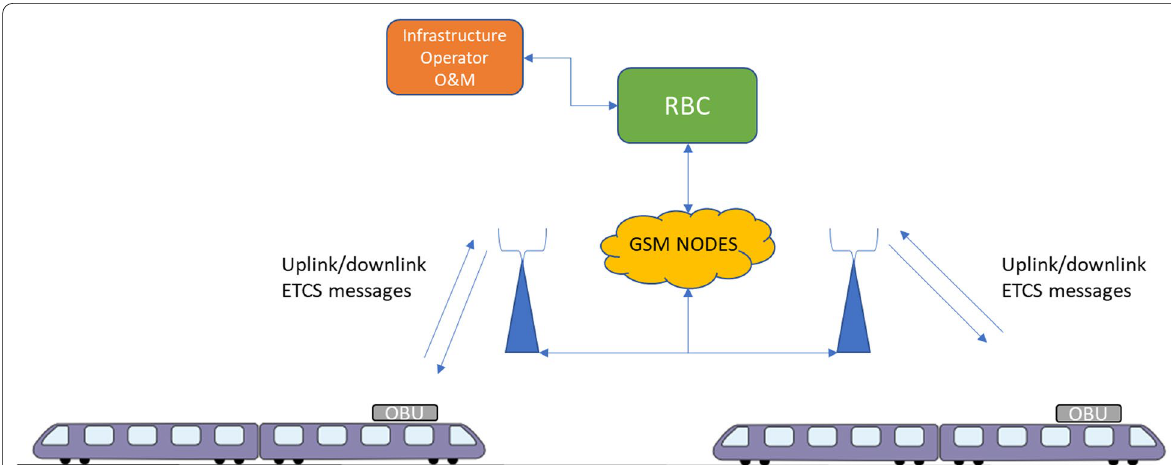
Fig. 1 ERTMS Level 2 radio communication overview